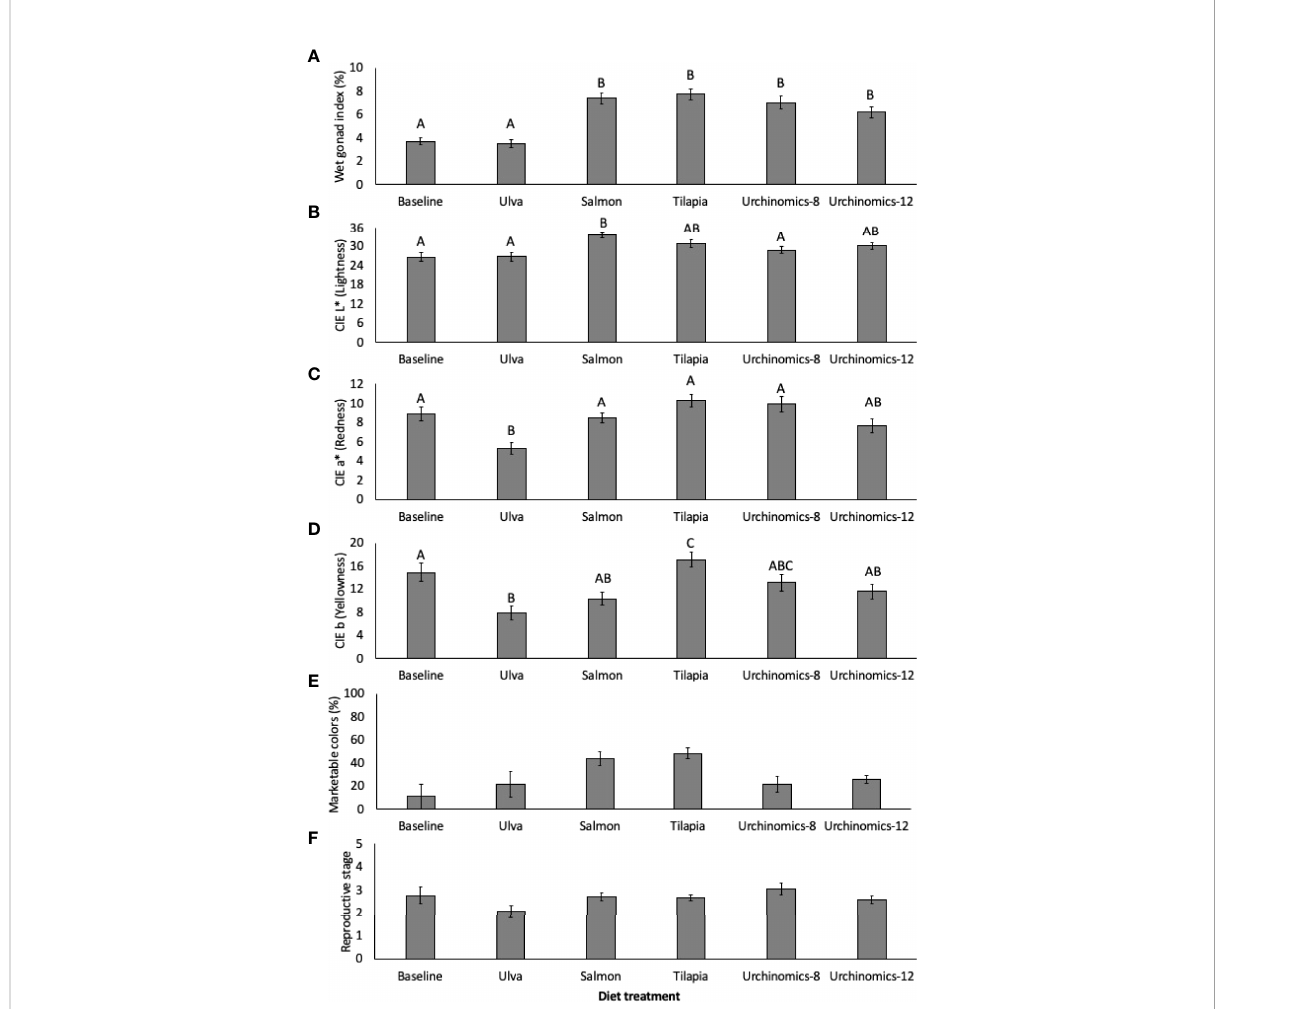
FIGURE 3 Mean (± SE) wet gonad index (%; A ), CIE L* (lightness; B ), CIE a* (redness; C ), CIE b (yellowness; D ), acceptable market gonad colors (%; E ) and median (± IQR) reproductive stage (F) of Arbacia punctulata fed different diet treatments. Letters above bars represent groups that are signi fi cantly different from each other, and where there are no letters indicate no signi fi cant treatment